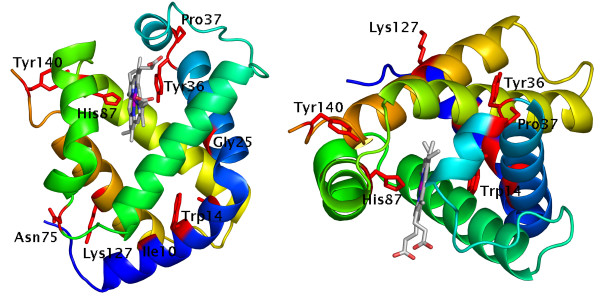
Significantly selected positions in chicken haemoglobin. The structure of chicken haemoglobin (PDB:1hbr) chain A is shown; residue backbones are coloured blue to orange from N to C terminal. Residues most strongly correlated with structural change are depicted in red. Figure created with PyMol (Delano Scientific, San Carlos, CA, USA).